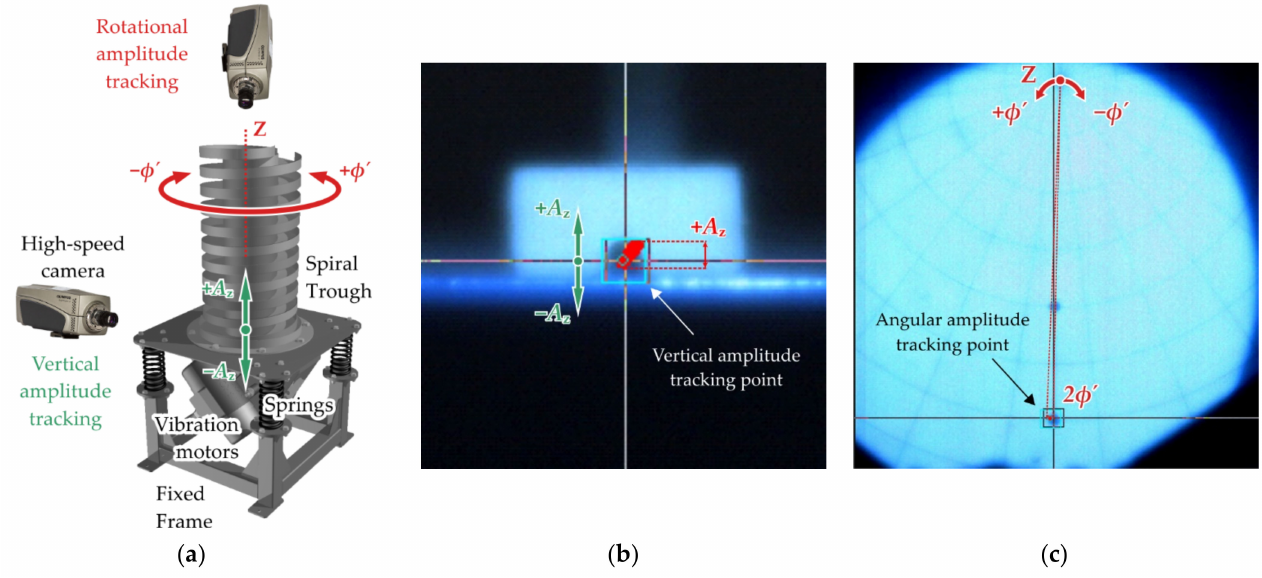
Figure 6. Spiral trough movement amplitudes tracking: ( a ) measurement scheme; ( b ) vertical amplitude A Z tracking; ( c ) angular amplitude ϕ ´